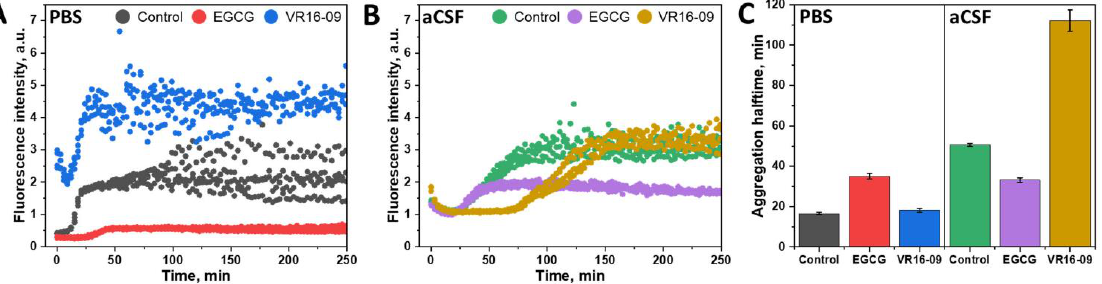
Figure 1. Aβ (2 μM) aggregation kinetics in PBS ( A ) and aCSF ( B ) in the absence or presence of 25 μM of oxidized EGCG or VR16-09 and their respective relative halftime values ( C ). The three separate repeats of each kinetic experiment are shown in the graphs. Error bars are one standard deviation (n = 4).